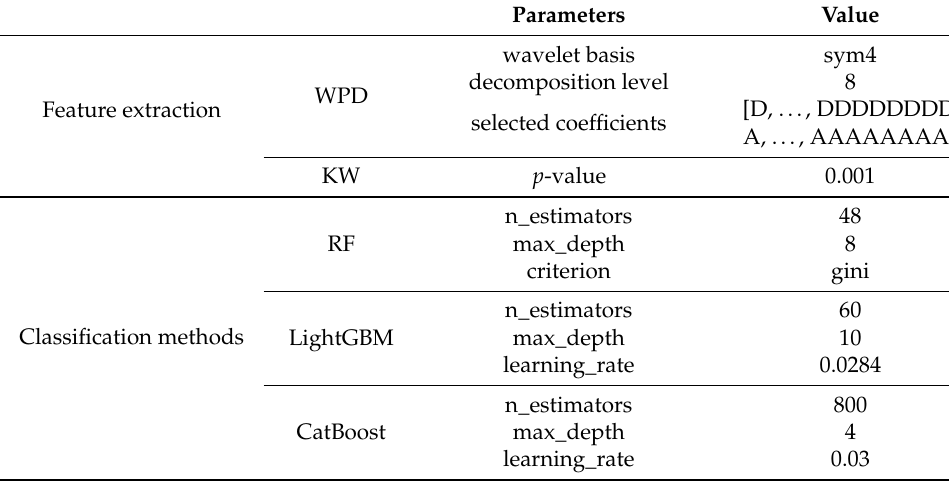
Table 2. Parameters for the proposed methodology in this